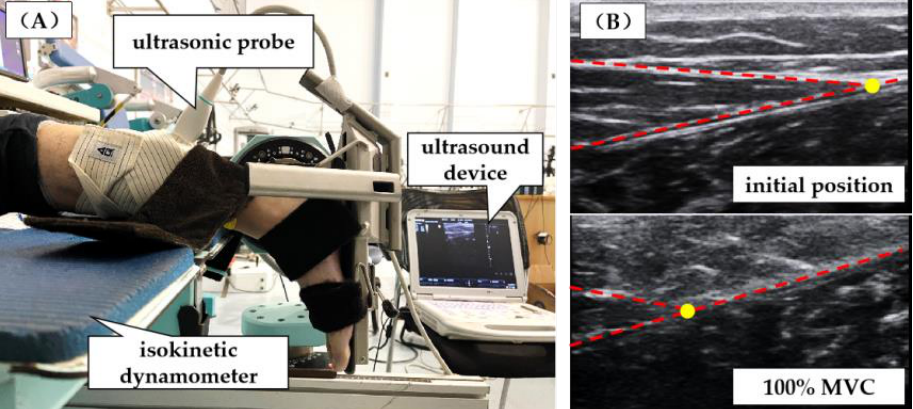
Figure 2. ( A ) Ultrasound probe attached to the dominant leg during the maximum voluntary contraction on the isokinetic dynamometer. ( B ) Ultrasound images of the myotendinous junction of the medial gastrocnemius (MG) head and Achilles tendon (AT). The yellow dot represents the point that is tracked in the image for each frame during the maximum voluntary contraction. To the left of the yellow dot is the MG muscle, and to the right is the AT. The thickness and CSA of the AT were analyzed at the level of the medial malleolus using ImageJ software (NIH, Bethesda, MD, USA). The thickness of the AT was measured by the maximum anteroposterior diameter of the tendon, and the CSA of the AT was measured by tracing the surrounding echogenic boundary of the AT. The length of the AT was calculated as the distance between the MTJ and the insertion point. MTJ displacement was tracked from the video with semi-automatic software Kinovea (version 0.8.15). The software requires the user to place one tracking point over the MTJ. The software tracked automatically initially, and then the experimenters confirmed whether the tracking point of each frame was in the correct position—i.e., at the MTJ—and manually adjusted it frame by frame. After tracking, MTJ displacement was output. Tendon elongation was calculated by subtracting the initial tendon length at rest, and the strain was calculated by dividing the elongation by the initial length. The AT force was calculated by deriving the PT on the dynamometer and moment arm of the AT (MA AT ): AT force = PT × MA − 1 AT where the default value of MAAT is 0.05 m, which is the average vertical distance from the ankle to the anterior border of the AT [23], and the AT force is normalized by the BW. AT stress was calculated from the AT force divided by the CSA. AT stiffness was calculated as the slope of the least-squares line of the ascending limb of the force–elongation curve between 50% and 100% of MVC force [2]. Hysteresis was calculated by subtracting the area under the descending limb of the force–elongation curve from the area under the ascending limb and dividing the difference by the area under the ascending limb (Figure